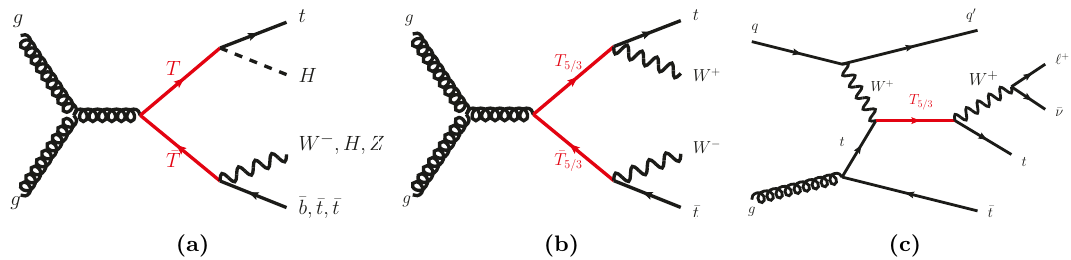
Figure 1 . Three examples of VLQ production with (a) pair-produced T , (b) pair-produced T and (c) singly produced T